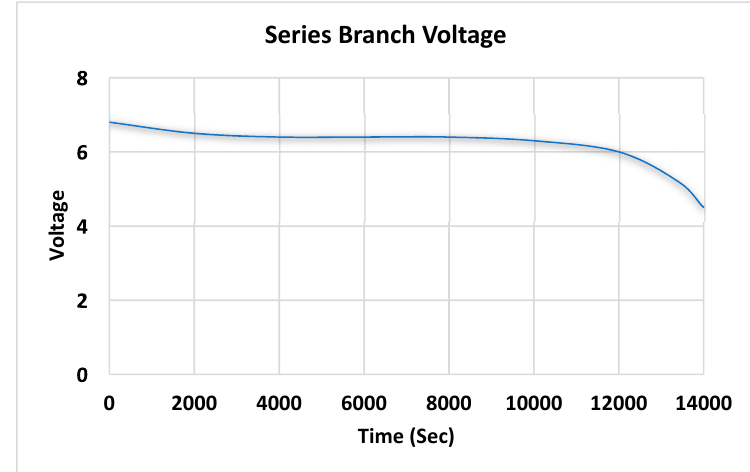
Figure 22. Our Simulink Simulation of the Storage Subsystem (Discharging).